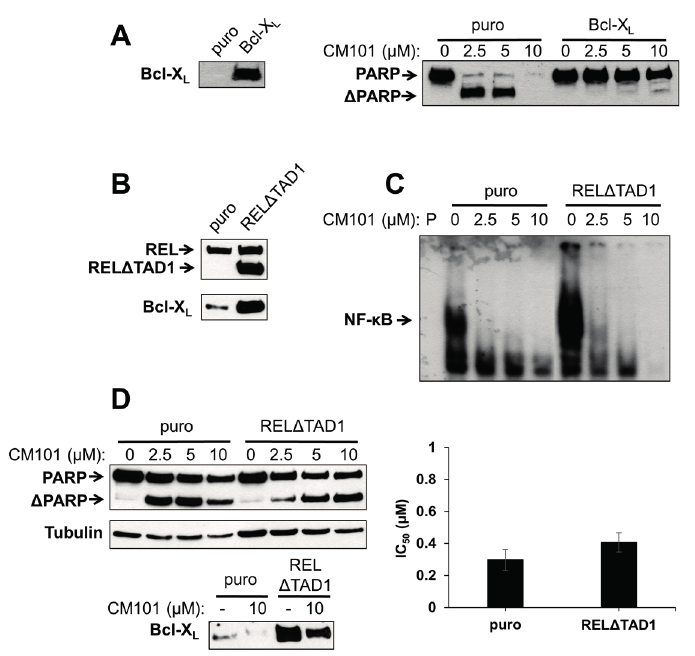
Figure 6. Ectopic expression of Bcl-X L or an activated REL mutant can protect B-lymphoma cells from CM101-induced apoptosis. ( A ) SUDHL-2 cells were infected with a pMSCV-puro empty vector or the same vector encoding Bcl-X L . Stable pools were selected with puromycin. The left panel is a western blot confirming stable overexpression of retrovirally transduced Bcl-X L . In the right panel, SUDHL-2-puro and SUDHL-2-Bcl-X L cells were treated with the indicated concentrations of CM101 for 24 h, extracts were prepared, and PARP cleavage was monitored by western blotting; ( B ) BJAB cells stably infected with pMSCV-puro empty vector or the same vector encoding REL Δ TAD1 [4] were analyzed by western blotting for REL and Bcl-X L ; ( C ) An EMSA with a κ B-site probe using extracts of BJAB-puro and BJAB-REL Δ TAD1 cells treated for 2 h with the indicated concentrations of CM101. P indicates probe alone; ( D ) BJAB-puro and BJAB-REL Δ TAD1 cells were treated with the indicated concentrations of CM101 for 24 h, extracts were made, and PARP cleavage was monitored by western blotting. β -Tubulin western blotting was performed as a loading control. In the bottom left panel, Bcl-X L levels were monitored by western blotting on extracts of BJAB-puro and BJAB-REL Δ TAD1 cells treated for 24 h with either the solvent methanol ( − ) or 10 μ M CM101 (+). In the right graph, BJAB-puro or BJAB-REL Δ TAD1 cells were treated with increasing concentrations of CM101, and cells were counted 72 h later. IC 50 values were calculated and plotted, as in Figure